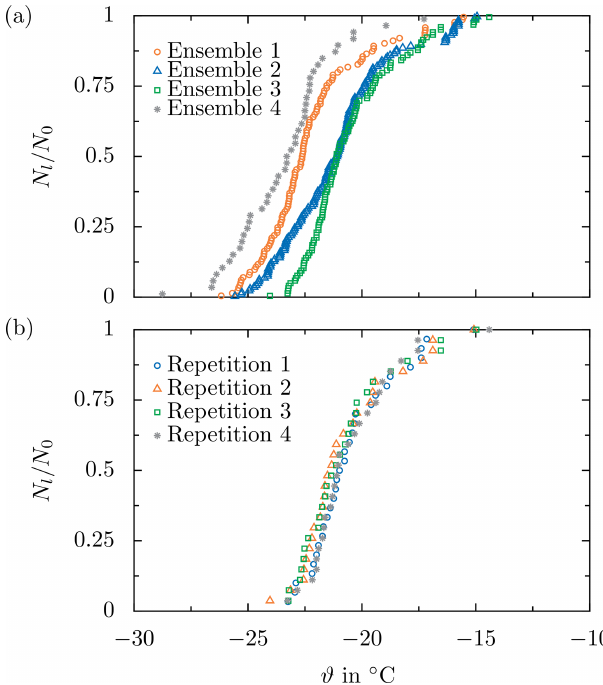
Figure 12. Demonstration of the present methodology by means of a comparison of the droplet survival curves obtained from several test runs without an electric field, performed using (a) four differ- ent droplet ensembles and (b) the same droplet ensemble for each of the four test runs. All data are obtained at ˙ T = 5Kmin − 1 . Re- published with permission of SAE International, from Löwe et al. (2019); permission conveyed through Copyright Clearance Center,